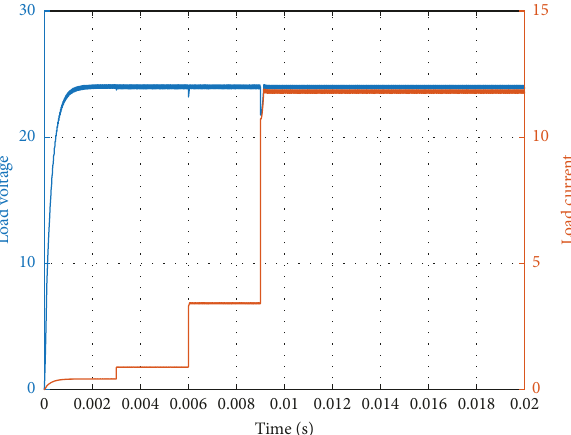
Figure 13: Plot for load current and voltage for varying load using the flower pollination algorithm-tuned QFT